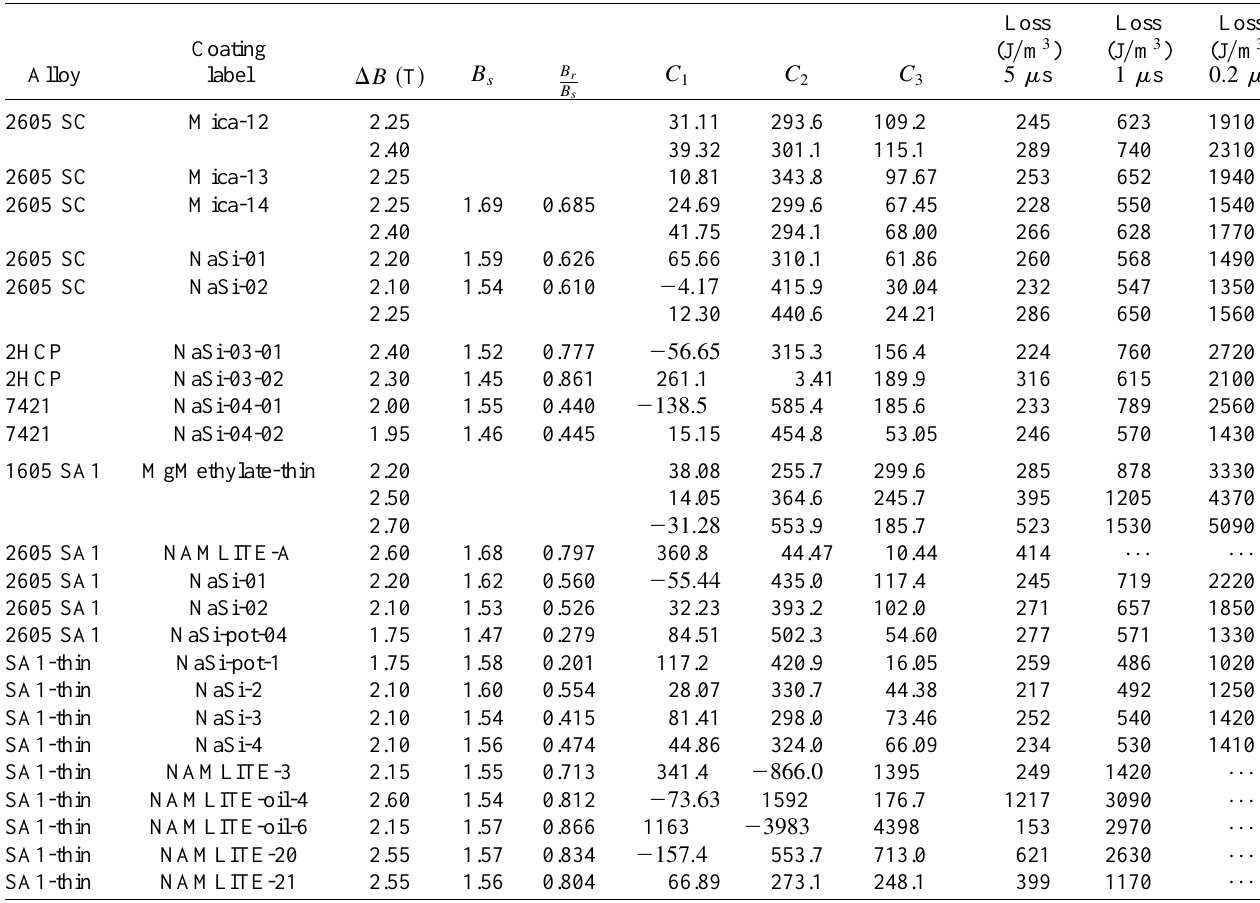
TABLE II. Each amorphous metal core reported in this paper is listed with its alloy, its coating and individual label, flux swing, saturation magnetic field, the ratio of the remanent to saturation magnetic field measured for dB (cid:2) dt (cid:5) 2 T (cid:2) m s, the best fit coefficients to Eq. (4) for the listed flux swing, and the losses computed from Eq. (4) for three pulse